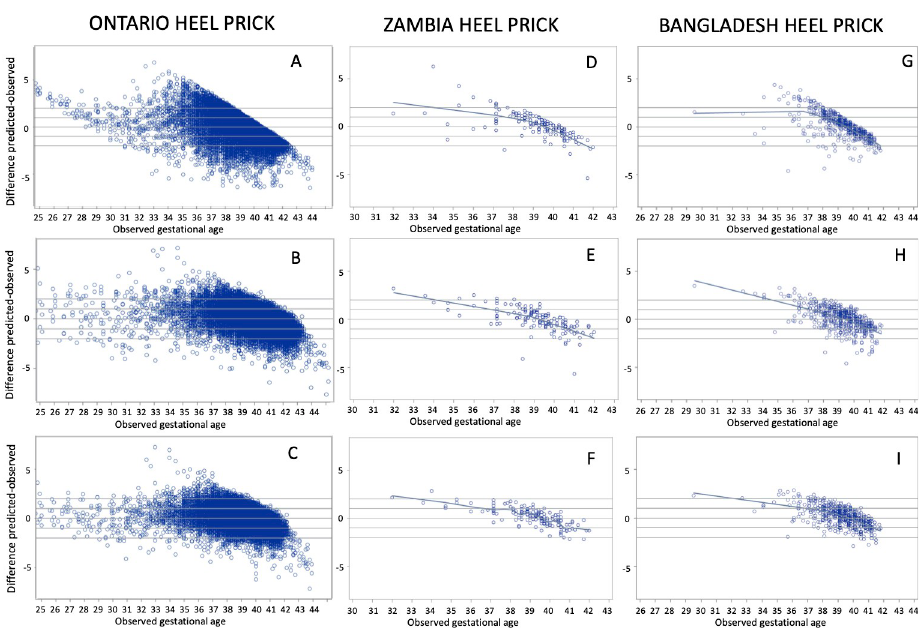
Fig 3. Residual plots of predicted–observed by ultrasound-assigned gestational age. Heel prick samples from Ontario : (A) Model 1: Baseline Model, (B) Model 2: Analyte Model, and (C) Model 3: Full Model. Heel prick samples from Zambia : (D) Model 1: Baseline Model, (E) Model 2: Analyte Model, and (F) Model 3: Full Model. Heel prick samples from Bangladesh: (G) Model 1: Baseline Model, (H) Model 2: Analyte Model, and (I) Model 3: Full Model.